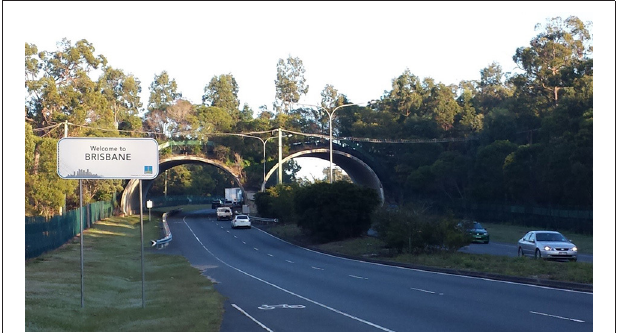
FIGURE 1 | Compton Road fauna overpass in 2015 (Photo: M. McGregor).